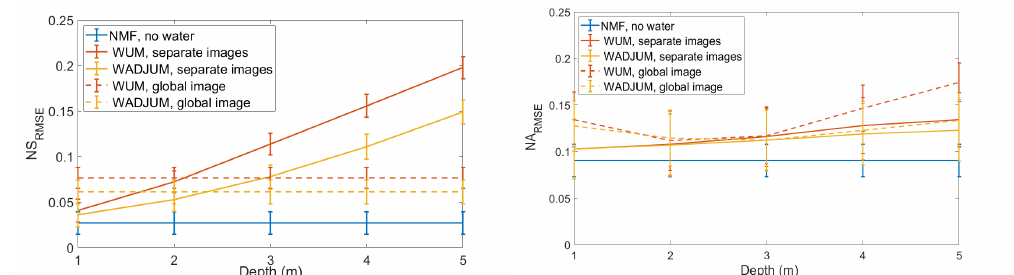
Figure 4. Normalized RMSE for endmember spectra ( NS RMSE ) and abundances ( NA RMSE ), for five separate constant seabed depth areas (plain lines), and for the entire image composed of all five areas (dashed lines), obtained using biased values of K 1 , K 2 and δ induced by a lack of knowledge for the water quality, in the case of moderately turbid water and z = [ 1,2,3,4,5 ]